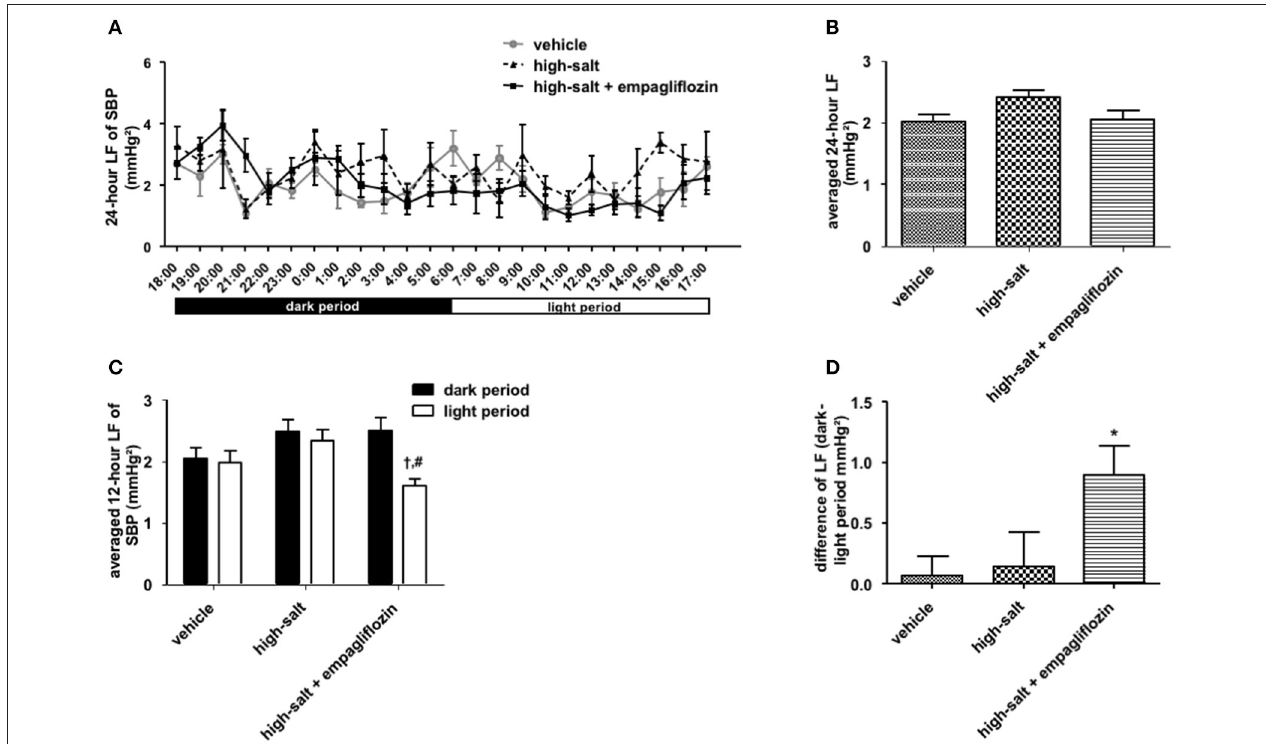
FIGURE 2 | Effects of empagliflozin treatment on low frequency (LF) of systolic blood pressure (SBP), and on circadian rhythm of LF of SBP, in Otsuka Long Evans Tokushima Fatty (OLETF) rats. (A) 24-h LF of SBP. (B) Average of 24-h LF of SBP. (C) LF of SBP in dark and light period. (D) Differences between dark and light period in LF of SBP. OLETF rats were treated with vehicle (vehicle, n = 7), 1% NaCl drinking water (high-salt, n = 5), or 1% NaCl drinking water and empagliflozin (high-salt + empagliflozin, n = 8), for 5 weeks. Values are mean ± SEM. † P < 0.001 vs. high-salt + empagliflozin dark period (2-way analysis), # P < 0.001 vs. high-salt light period ( t -test), * P < 0.05 vs. vehicle (one-way analysis of variance followed by Tukey’s multiple comparison